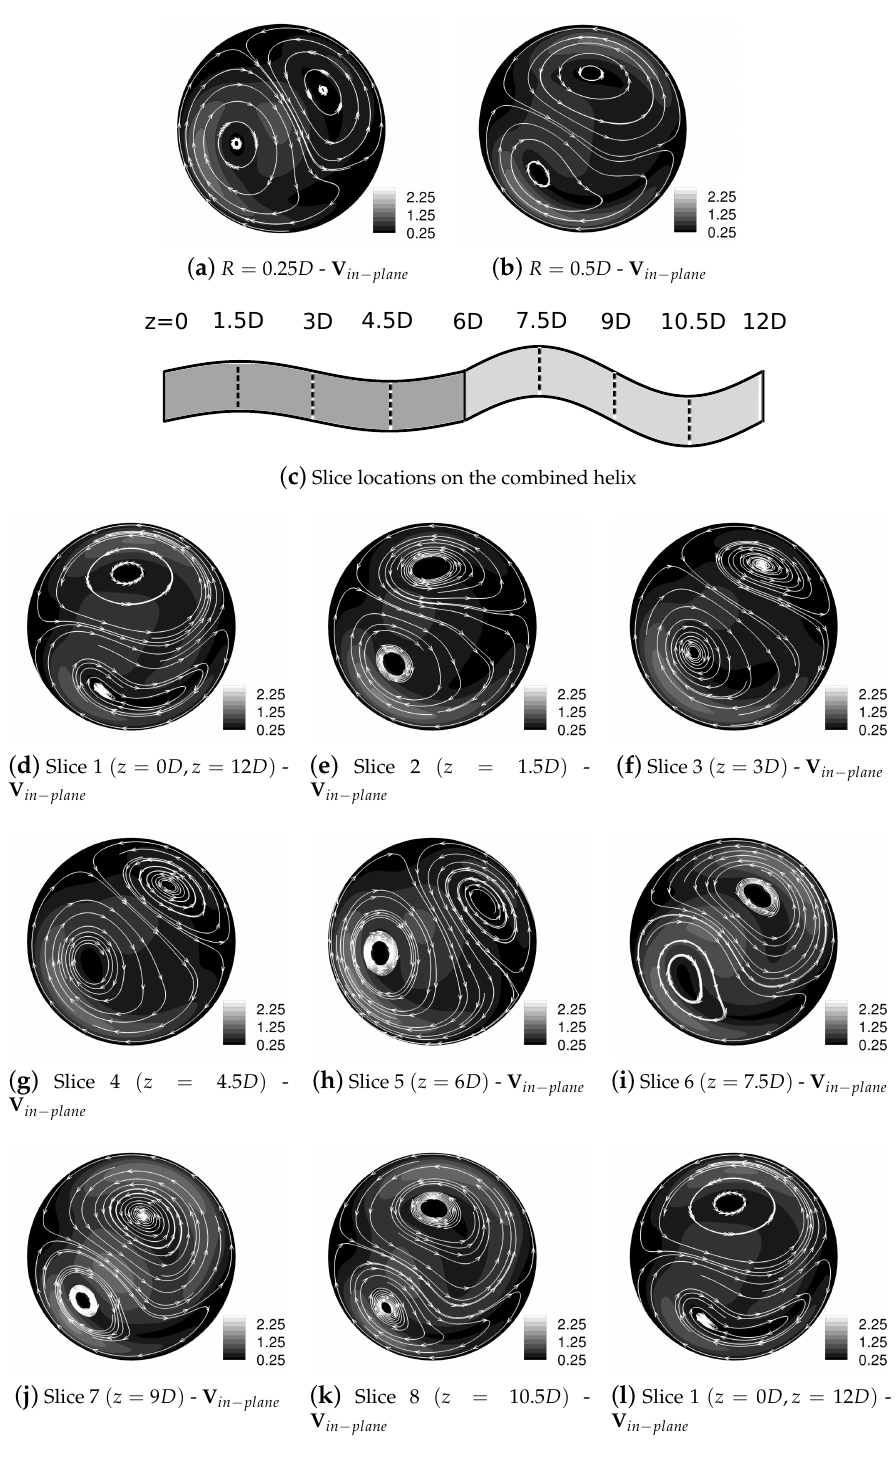
Figure 13. Streamtraces of V in − plane (cm/s) for R A = 0.25 D and R B = 0.5 D , Re = 250. ( a , b ) show the streamtraces from the single helical geometries, with ( d – f ) showing results from the combined geometry. The velocity field at z = 0, in ( d ), in the combined geometry corresponds closely to that for R = 0.5 D , in ( b ), whereas at z = 6 D , in ( h ), the streamtraces are close to those for R = 0.25 D in ( a ). Note that in contrast to Figure 14, the streamtraces correspond even more closely to those in the single helical geometries, due to the reduced spatial asymmetry in the flow structures between the two component